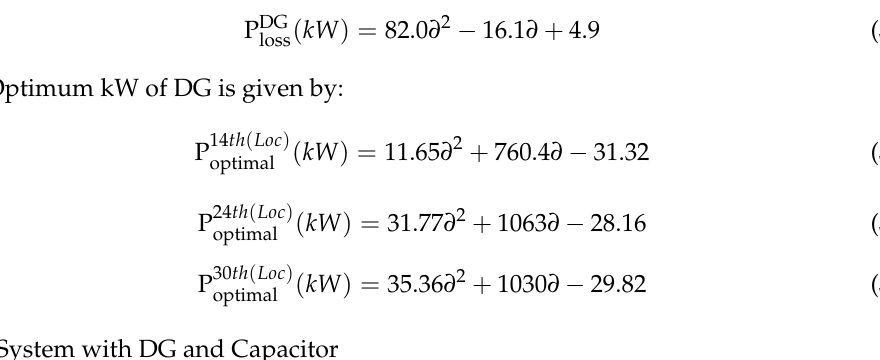
Figure 3. ( a ) Optimum kVAr for the capacitor under various load factors (IEEE 33-Bus). ( b ) Optimum kW for DG under various load factors (IEEE 33-Bus).